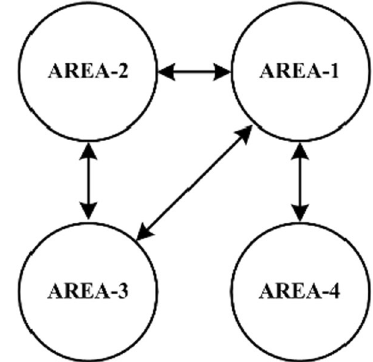
Fig. 8 Schematic diagram of the four-area